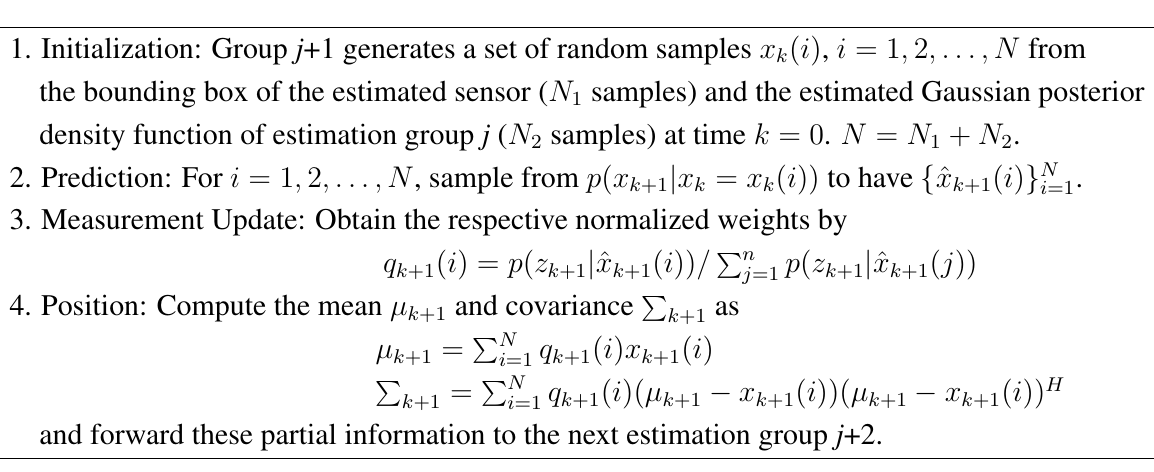
Table 4. The Progressive Estimation